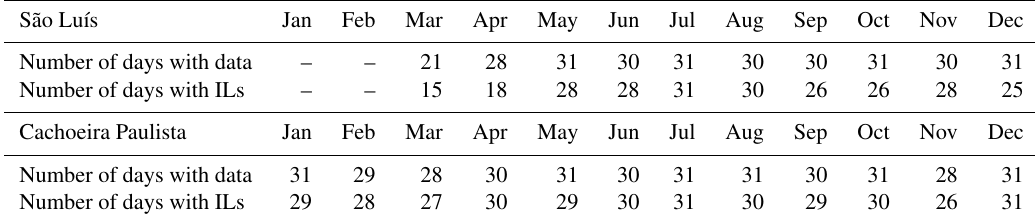
Table 1. Number of days used in our